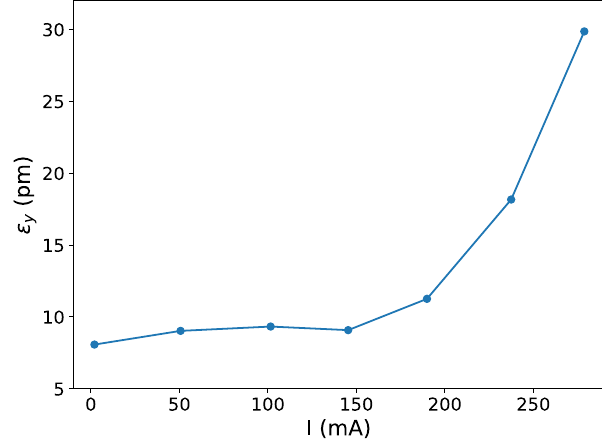
FIG. 12. Integrated quadrupole strength which is needed to compensate for the quadrupolar wakefields at different beam currents.